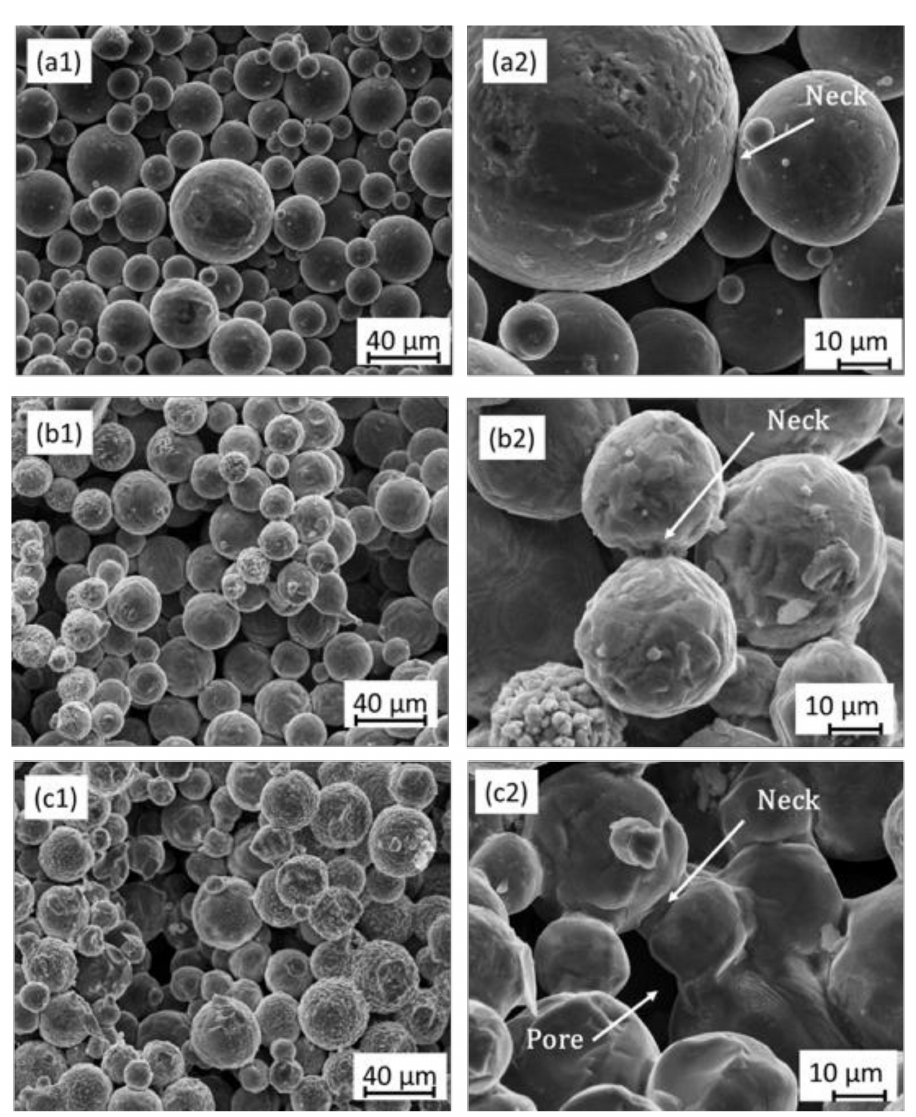
Figure 3. Scanning electron microscopy images for the titanium alloy components processed at: ( a1 , a2 ) St —950 ◦ C; ( b1 , b2 ) St —1150 ◦ C; and ( c1 , c2 ) St —1350 ◦ C; Hr —10 ◦ C/min and Ht —60